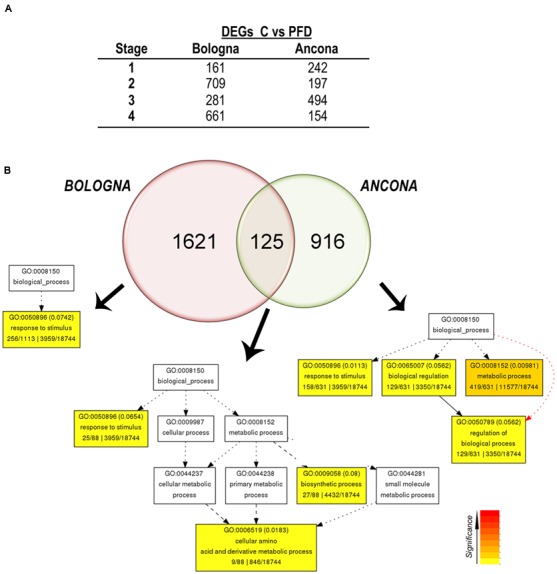
Transcriptomic responses to PFD treatment in two different sites. (A) Differentially expressed genes (t-test with a α = 0.01) between C and PFD vines at each sampling time point in the two sites. (B) Venn diagram summarizing results obtained in (A) was constructed using Venny 2.1.0 and redrawn. (C) Gene Ontology (GO) enrichment analysis was performed, using the AgriGO online software (Du et al., 2010), on Bologna-, Ancona-, and common PFD modulated transcripts separately. Statistically significant GO categories are highlighted in color, according to the given significance color-key.